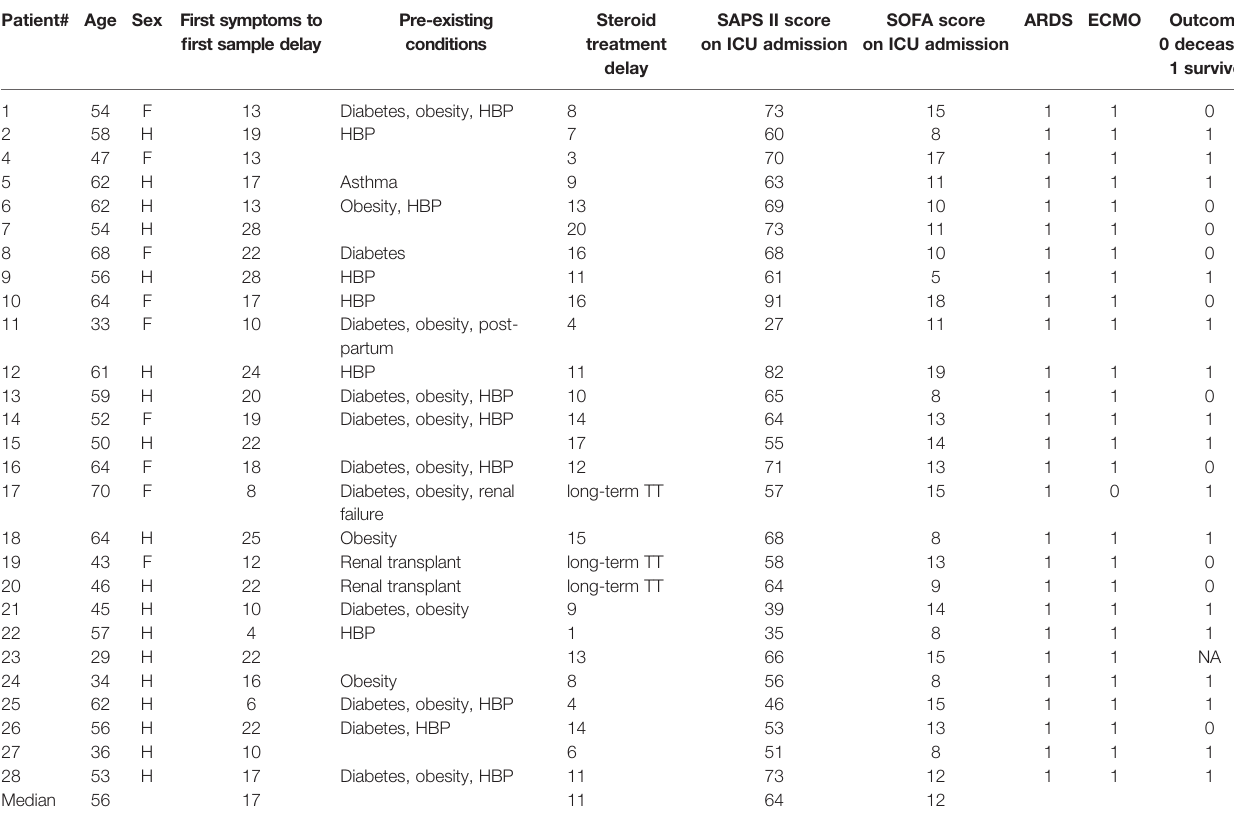
TABLE 2 | Very severe ICU patients with COVID-19 infection: second wave. Patient# Age Sex First symptoms to fi rst sample